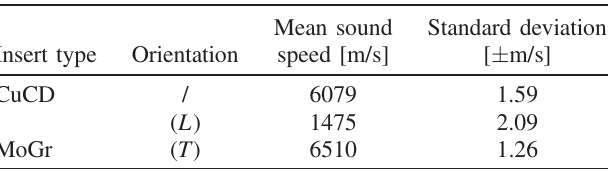
TABLE V. Mean speed of sound for respective material